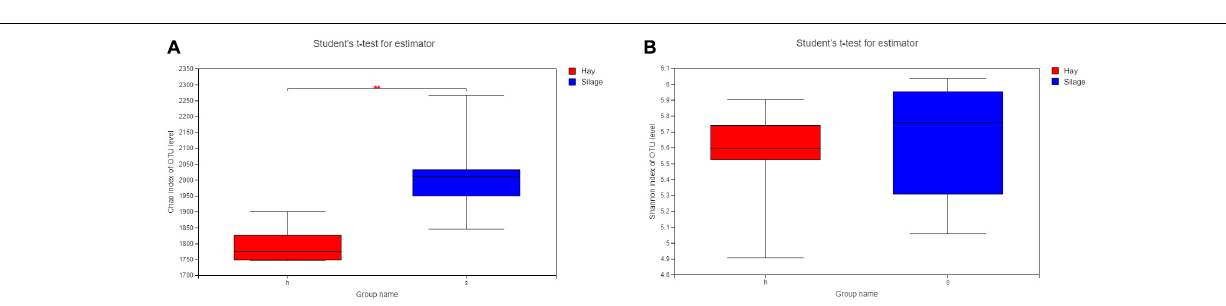
FIGURE 2 | Alpha diversity indices of the fecal microbiota in horses fed silage (S, n = 6) and hay (H, n = 6), ** P < 0.01. (A) Bacterial taxa richness or Chao index of each group (B) Bacterial taxa diversity of Shannon index of each group. Red, group H; Blue, group